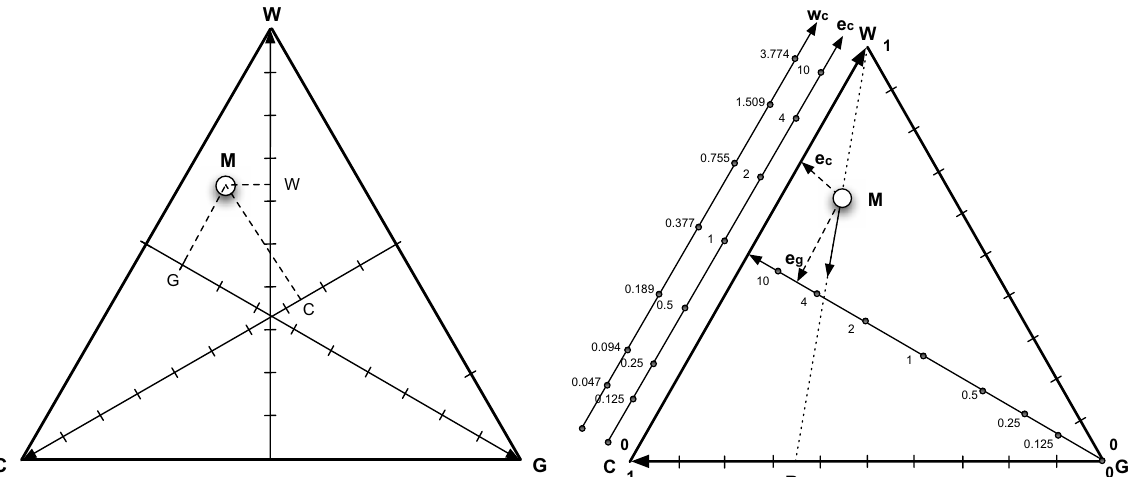
Fig. 1 – Triangular representation of saturated sand clay mixtures. On the left, determination of the mixture composition with of the volume ratio parameters C , W , G . On the right, identification of the two control parameters e c and e g . The extended line WM corresponds to mixtures of identical R c and indicates the consolidation path in oedometer